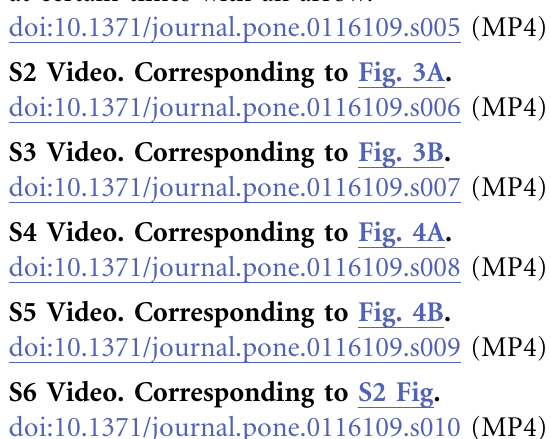
S4 Fig. Immunofluorescence detection of Ezh2 using HP3-10 ES cells differentiated for 50 hours under the epiLCs protocol. Bottom panel: DAPI staining. Middle panel: Ezh2 signal alone. Top panel: Ezh2 and DAPI surimposed. Cells with a single nuclear foci of Ezh2 as well as cells with two nuclear foci of Ezh2 are present. doi:10.1371/journal.pone.0116109.s004 (TIF) S1 Video. A cell showing 2 Ezh2-Venus fluorescent nuclear territories performed 2 cell divisions over a 24-hours tracking. Cells of interest are pointed at certain times with an arrow. doi:10.1371/journal.pone.0116109.s005 (MP4) S2 Video. Corresponding to Fig. 3A. doi:10.1371/journal.pone.0116109.s006 (MP4) S3 Video. Corresponding to Fig. 3B. doi:10.1371/journal.pone.0116109.s007 (MP4) S4 Video. Corresponding to Fig. 4A. doi:10.1371/journal.pone.0116109.s008 (MP4) S5 Video. Corresponding to Fig. 4B. doi:10.1371/journal.pone.0116109.s009 (MP4) S6 Video. Corresponding to S2 Fig.